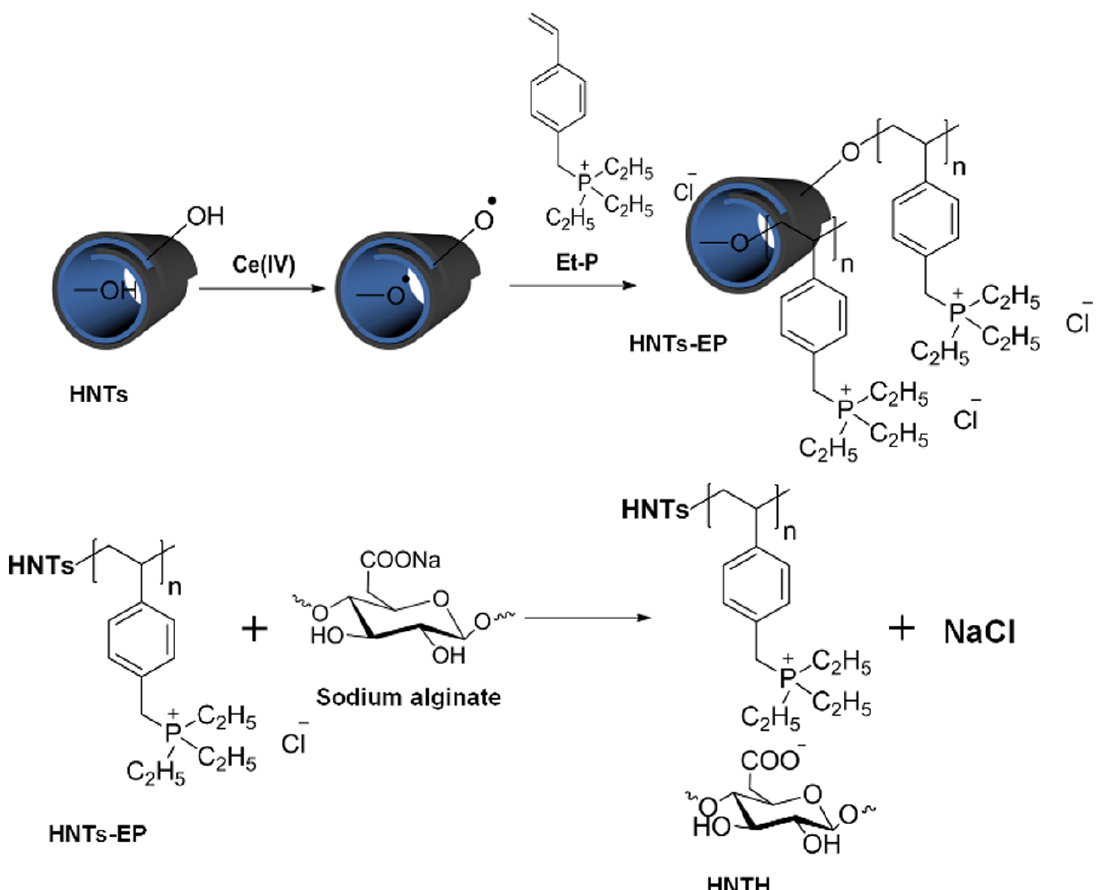
Figure 8: Grafting poly(triethyl(4-vinylbenzyl)phosphonium chloride) onto HNT by a redox system consists of Ce(IV) and -OH groups located on HNTs and the preparation of a hydrogel